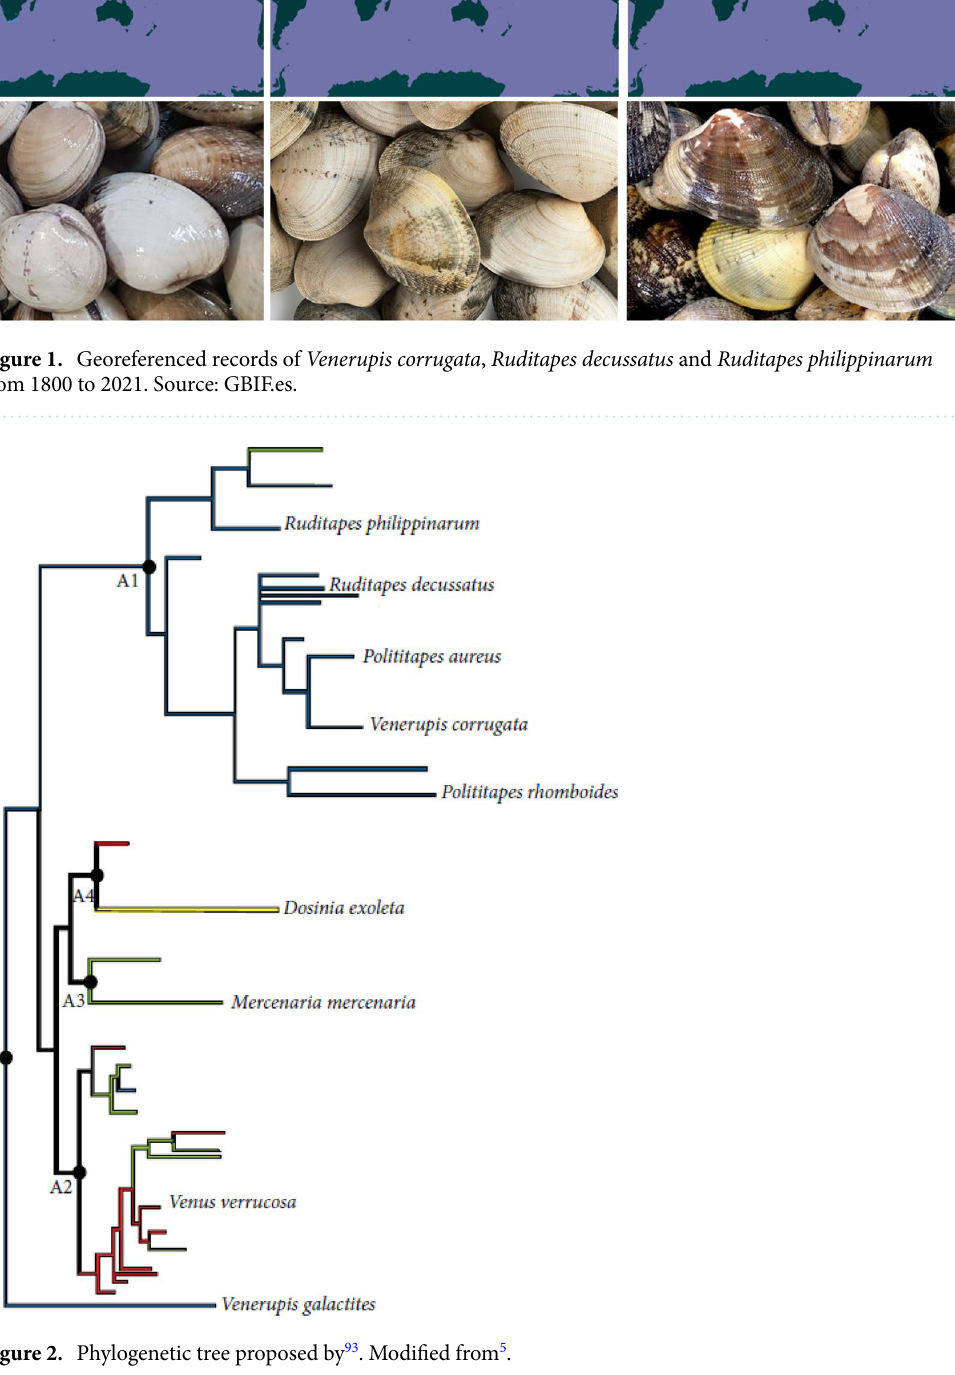
Figure 2. Phylogenetic tree proposed by 93 . Modified from 5